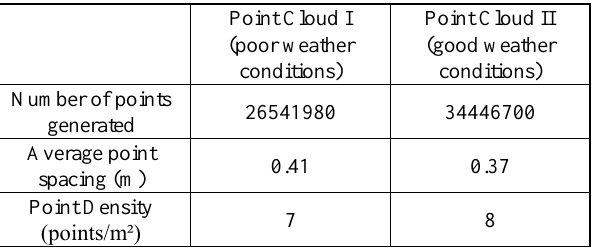
Table 3. Statistics for generated